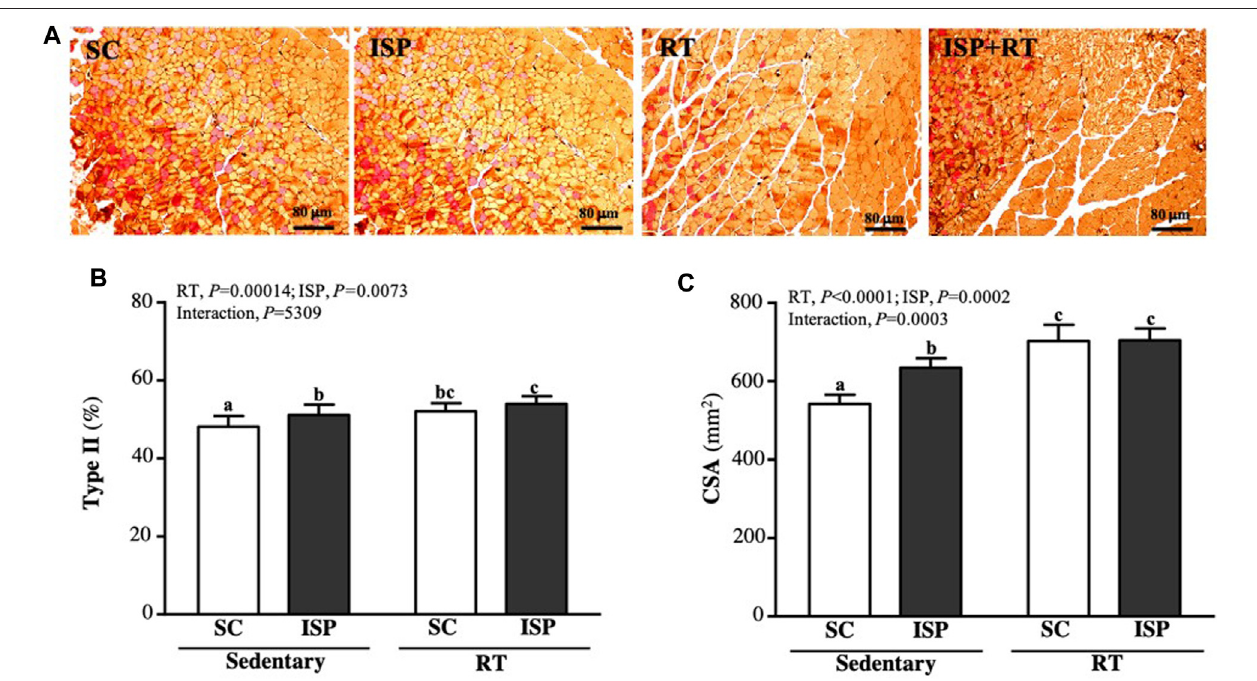
FIGURE7| Effect ofISPsupplementationandRTofagingmiceon (A) muscleofthighwithIHCstaining, (B) musculartypeproportions, and (C) crosssectionarea (CSA).Specimenswerephotographedunderalightmicroscope(Hematoxylinandeosinstain,magni fi cation:×200;scalebar,40 μ m).Dataareexpressedasmean±SD for n = 8 mice per group. Different superscript letters (a and b) indicate signi fi cant difference at p < 0.05.